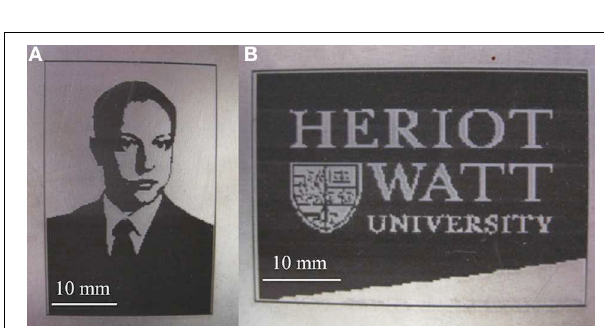
FIGURE 10 | Examples of marking on titanium (A,B) using 60 ns pulses (1064nm) delivered via the NCF [50].